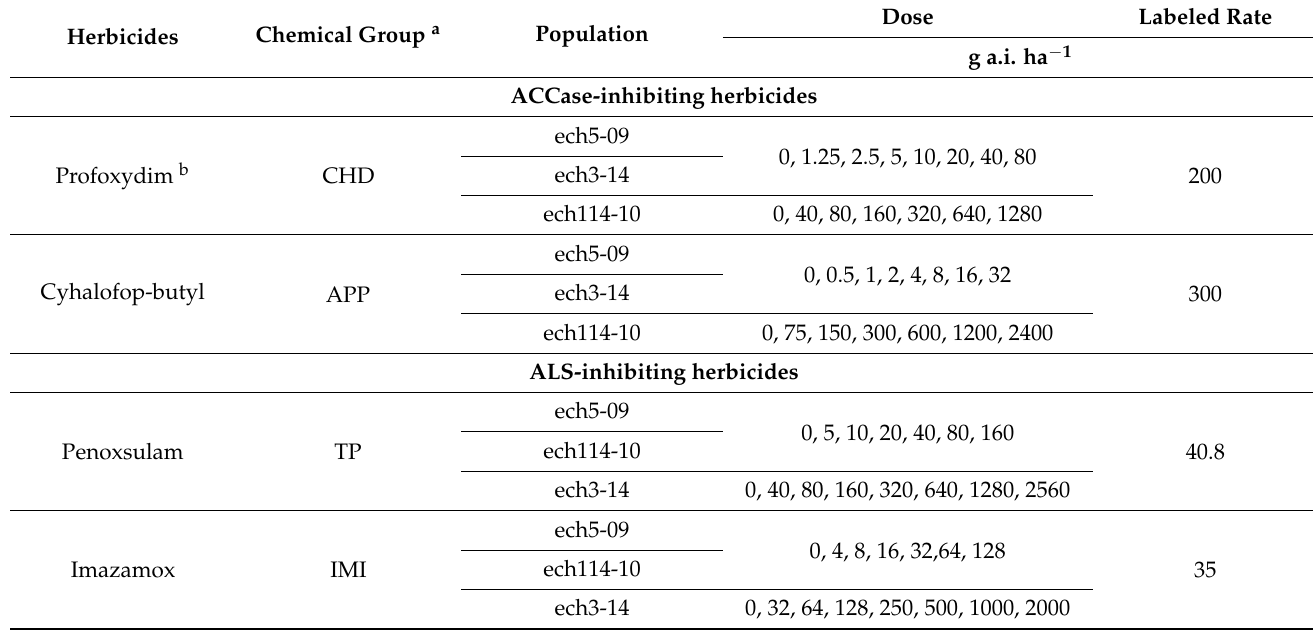
Table 3. Herbicide treatments applied for the dose–response